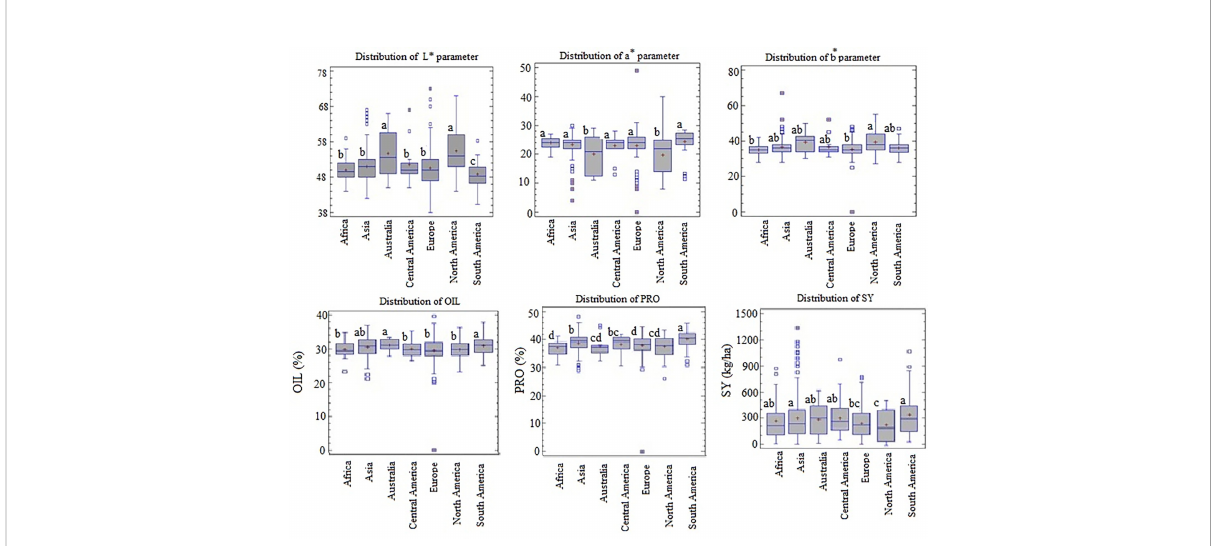
FIGURE 3 Variation distribution of seed color parameters, quality traits and seed yield of 144 fl ax genotypes from 7 different geographical origins over two years. The different letters in the upper plot denote statistically signi fi cant differences among the geographic origin (LSD =